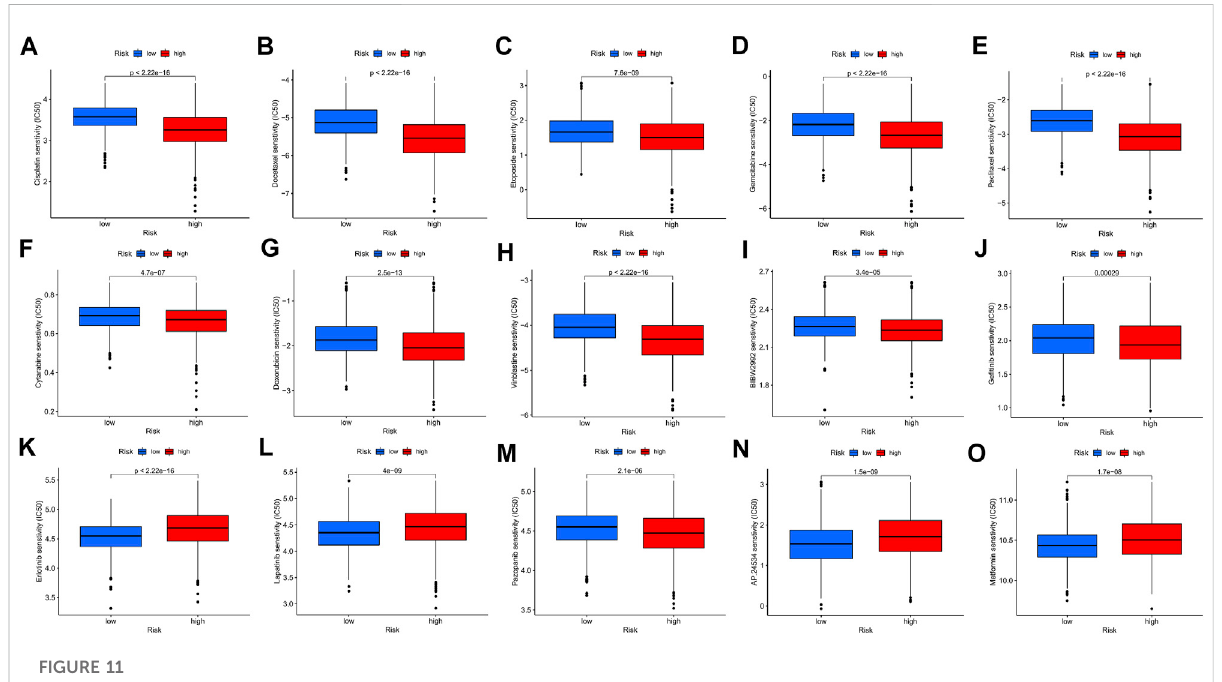
FIGURE 11 Association of the m7G-Riskscore with drug